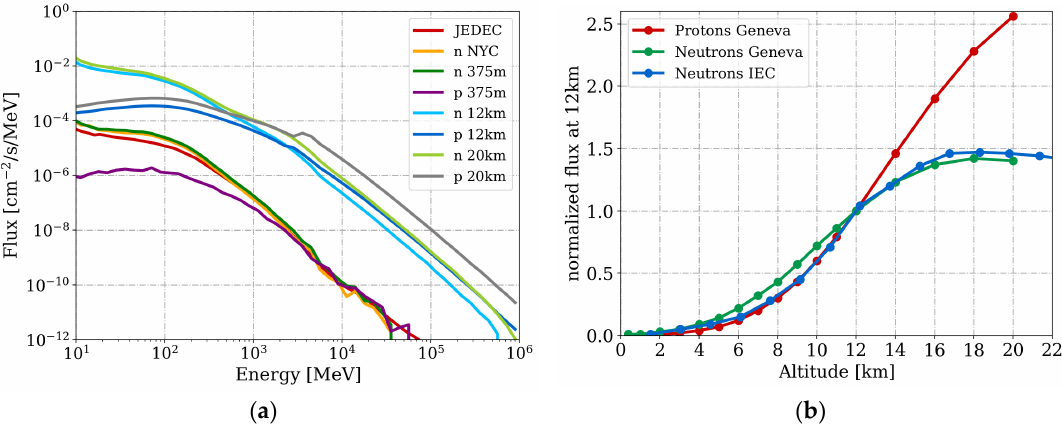
Figure 2. ( a ): Comparison between neutron and proton differential spectra above 10 MeV at ground level (Geneva, NYC, JEDEC NYC), 12 km and 20 km over Geneva. ( b ) Simulated neutron and proton fluxes (above 1 MeV) vs altitude, normalized at 12 km, in comparison to the Boeing model from the IEC1 standard (which is calculated from 1 to 10 MeV).